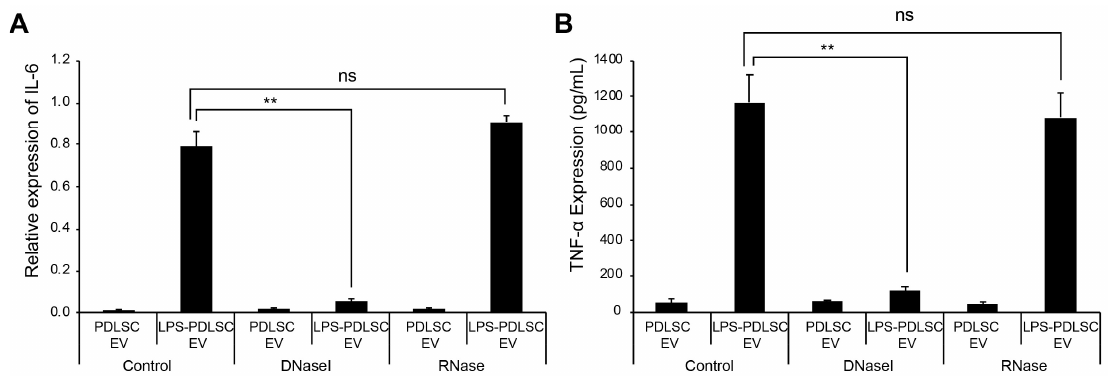
Figure 8. Treatment of EVs with DNase I abolished M1 polarizing effect in THP-1 cells. EVs from PDLSCs or LPS-preconditioned PDLSCs were treated with DNase I or RNase. Each EV sample was applied to THP-1 cells and the M1 polarization was analyzed by RT-qPCR and ELISA. ( A ) mRNA expression of IL-6 in THP-1 cells treated with each indicated EV sample. ( B ) TNF- α expression in the culture supernatant from THP-1 cells treated with each indicated EV sample. Data shown as the mean ± SD, n = 3, ns: Not significant, ** p < 0.01.